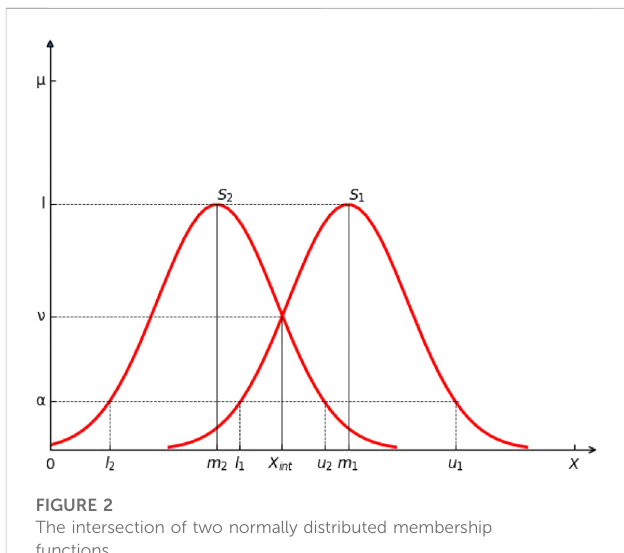
FIGURE 2 The intersection of two normally distributed membership